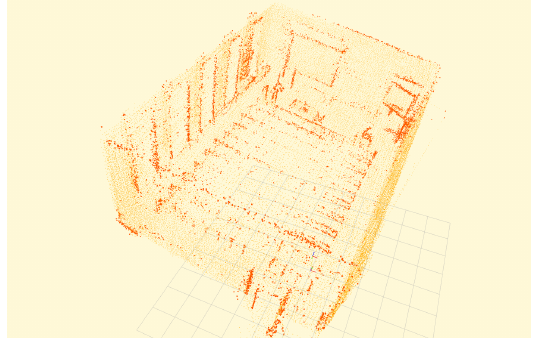
Figure 3. An example of a map that is used within the lidar mapping algorithm. Dark orange points were extracted as edge points while light orange points were extracted as planar